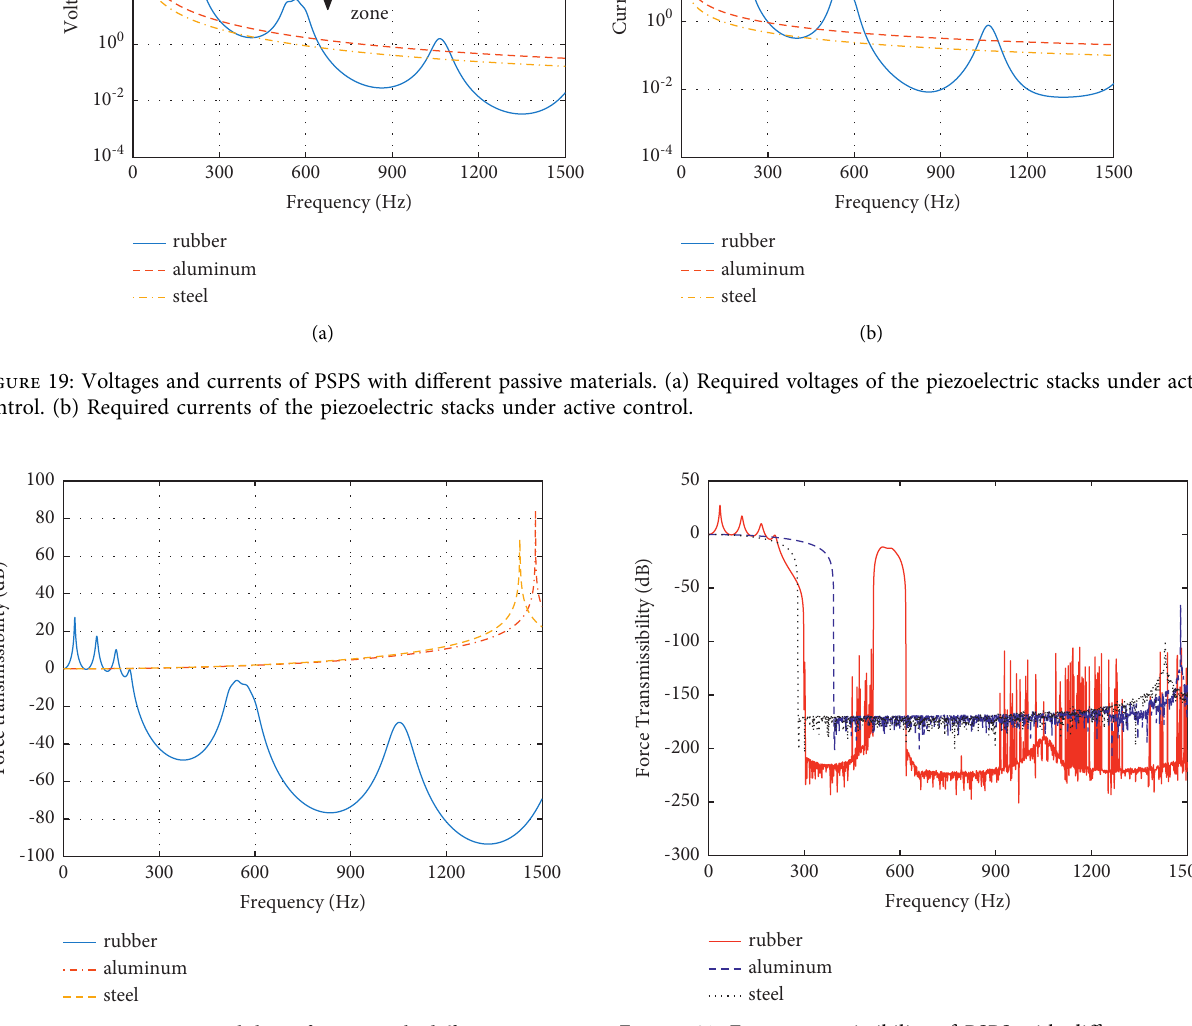
Figure 20: Force transmissibility of PSPS with different passive materials under short-circuited.